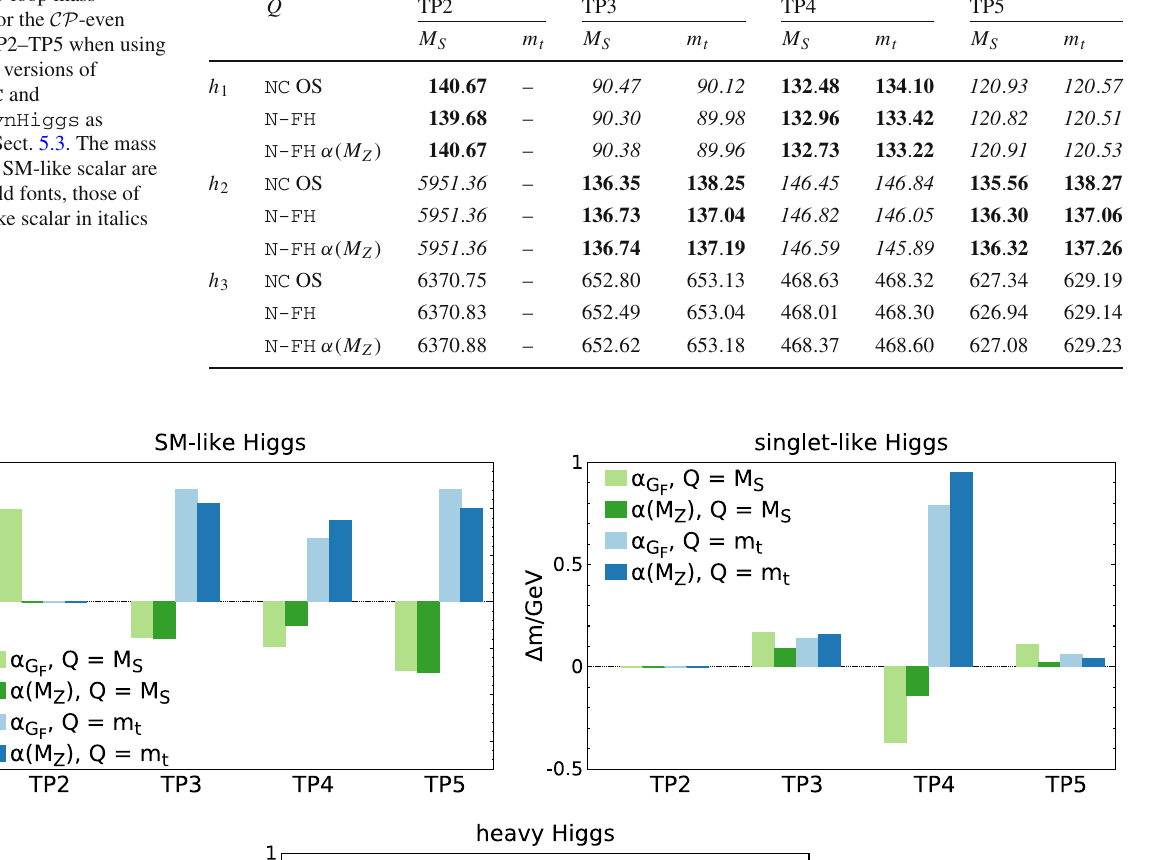
predictions for the CP -even scalars for TP2–TP5 when using the indicated versions of NMSSMCALC and NMSSM-FeynHiggs as specified in Sect. 5.3. The mass values of the SM-like scalar are written in bold fonts, those of the singlet-like scalar in italics